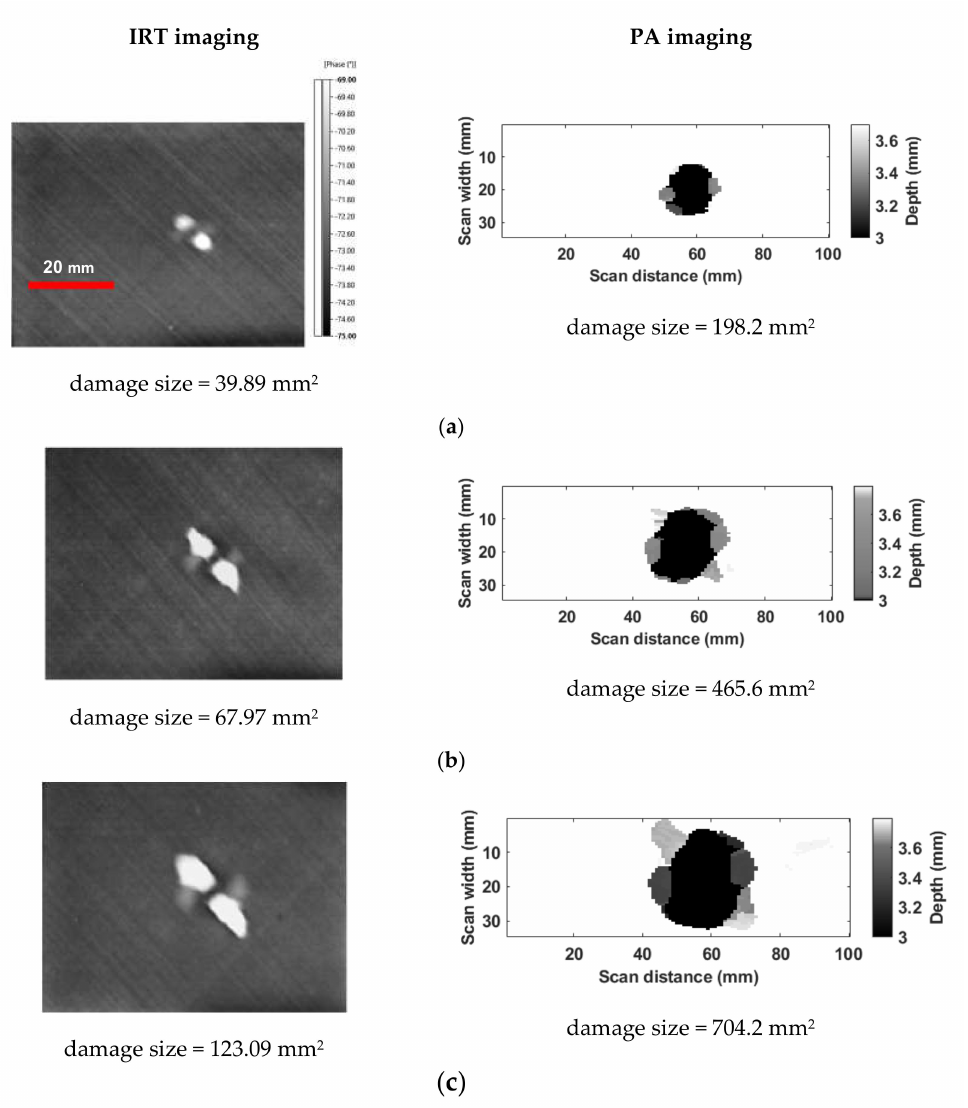
Figure 5. Detection of damage by rapid PPI-LT (thermograms, left column) and subsequent high-resolution characterization by PA imaging (right column) for 18-layers coupons with different impact energies: ( a ) 8 J, ( b ) 12 J, and ( c ) 20